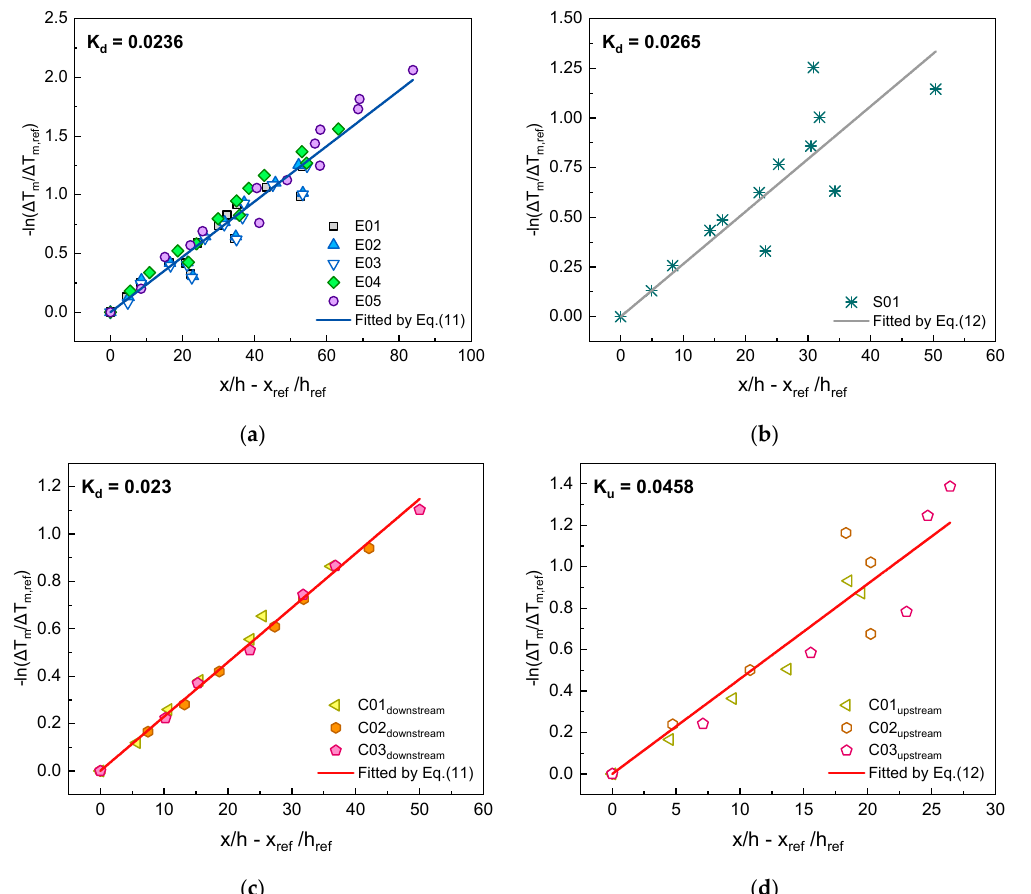
Figure 19. Fitting results of the longitudinal maximum gas temperature distribution in: ( a ) Test E01–05; ( b ) Test S01; ( c ) Test C01–03 downstream; ( d ) Test C01–03 upstream. Table 4. Fitting results of all full-scale tests.